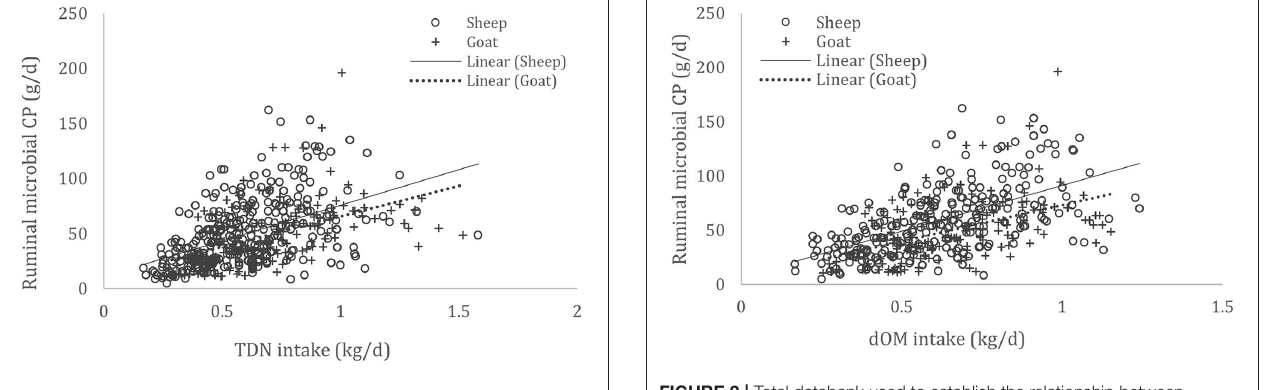
FIGURE 1 | Total databank used to establish the relationship between total digestible nutrient (TDN) intake (kg/day) and microbial crude protein (MCP—g/day) produced in the rumen of sheep and goats, made from 19 experiments ( n = 492).